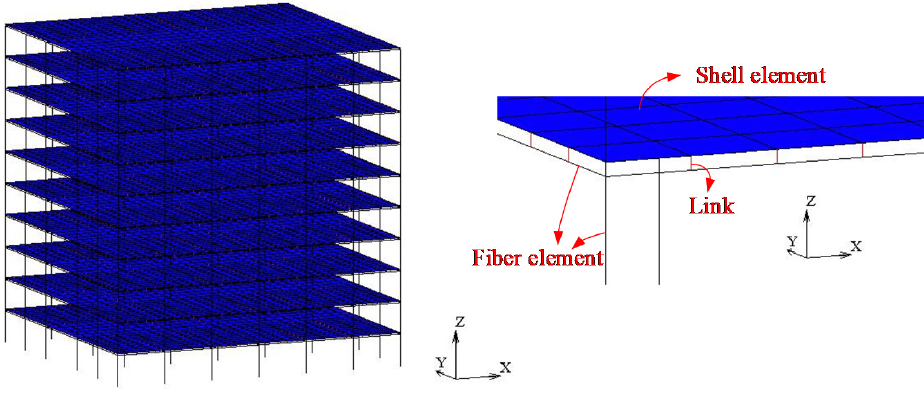
Figure 5. FE model of the investigated structure in MSC.Marc.